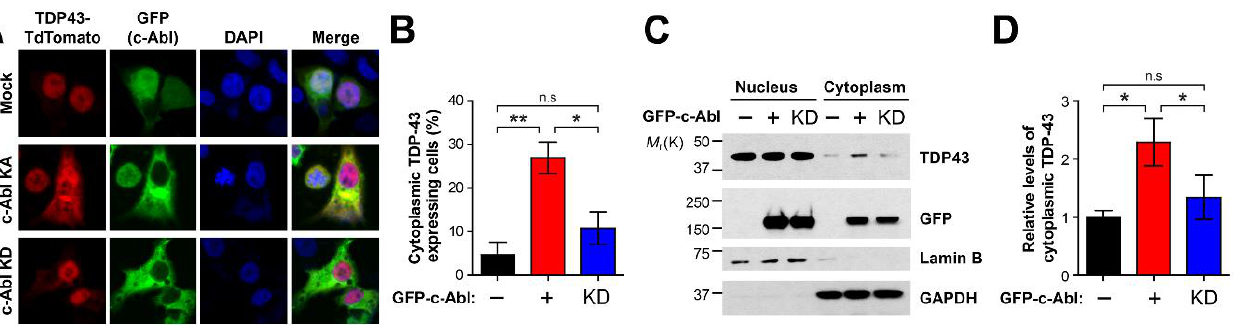
Figure 4. Y43 residue of TDP-43 associates with the TDP-43 pathology. ( A ) Immunostaining with G3BP1 antibody that can detect cytoplasmic stress granules in SH-SY5Y cells transfected with GFP- WT TDP-43, GFP-phospho-mimic forms of Y43E and Y155E TDP-43. ( B ) Quantification of the per- centage of cells with cytoplasmic stress granules (n = 3). Statistical significance was determined by using one- way ANOVA with Tukey’s correction; * p < 0.05, n.s. = non-significance. ( C ) Increased localization of TDP-43 at neurite granules by c-Abl KA co-expression in cultured cortical neurons. TDP-43 TdTomato and EGFP-c-Abl were expressed in the cultured cortical neurons and followed by immunocytochemistry. ( D ) Phospho-mimic form of TDP-43 Y43E showed increased neurite granule expression than TDP-43 WT in primary cultured cortical neurons. EGFP-TDP-43 WT and Y43E were expressed alone in the cultured cortical neurons and followed by immunocytochemical alayses. 3.5. c-Abl – Mediated Aggregation of TDP-43 Induces Neuronal Cell Death It has been proposed that the mislocalization of TDP-43 could nucleate the cytoplas- mic inclusions at the stress granules as a site of initial TDP-43 aggregation [32]. To assess the effect of c-Abl – induced phosphorylation on formation of TDP-43 aggregation, pri- mary cortical neurons cultured from WT and c-Abl knockout (KO) mice were transduced with lenti-virus expressing TDP-43 WT or phosphor-mimetic Y43E mutant. After 7 days post-infection, cellular proteins were sequentially extracted in Triton X-100 and urea con- taining buffers. Unlike the levels of soluble TDP-43, insoluble TDP-43 full-length and CTFs in urea fraction were increased in TDP-43 WT overexpressed neurons. The accumu- lation was further exacerbated in TDP-43 Y43E overexpressed neurons (Figure 5A). How- ever, in c-Abl KO neurons, the induction of TDP-43 WT failed to accumulate insoluble